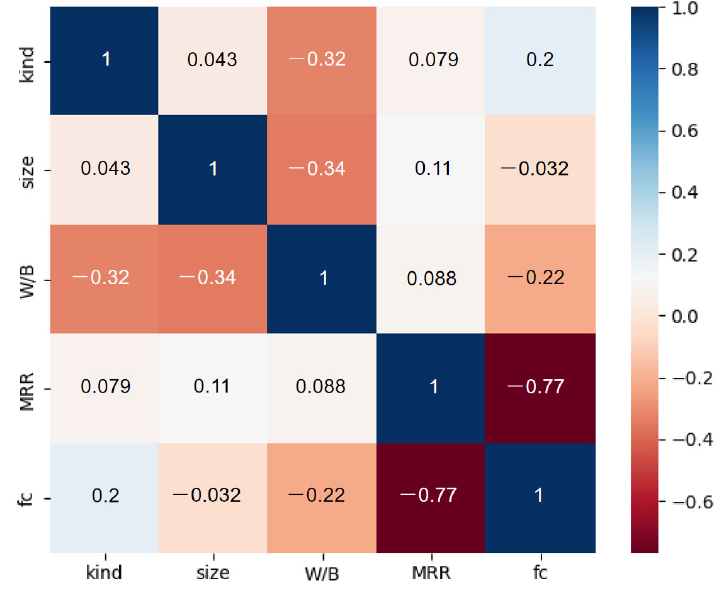
Figure 2. Person correlation coefficient plot of the variable.